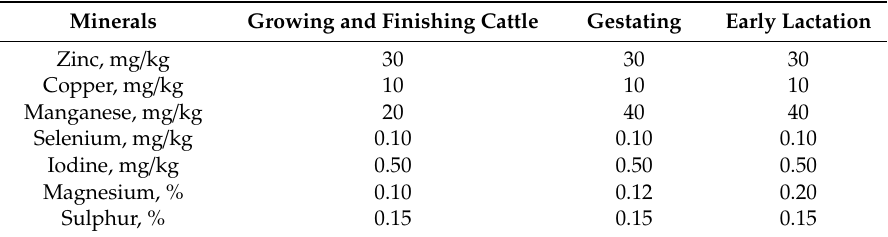
Table 2. Mineral Requirements for dairy